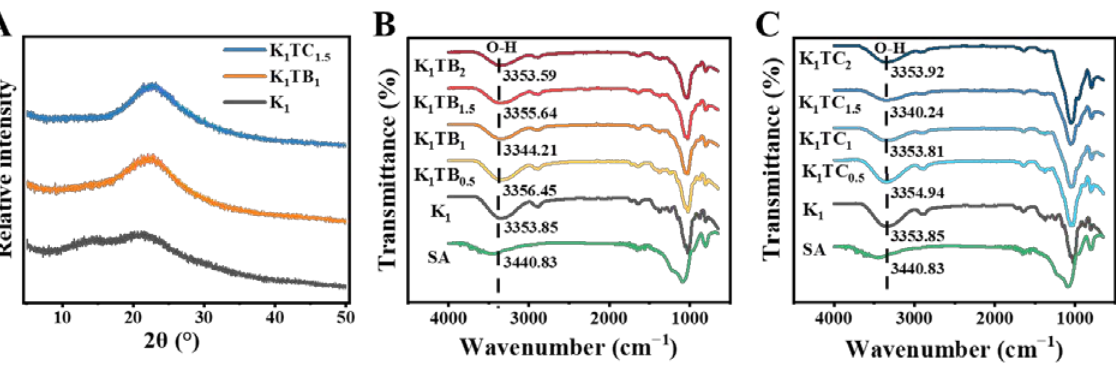
Figure 2. XRD spectra of aerogels ( A ) and FTIR spectra of KTB aerogels ( B ) and KTC aerogels ( C ).